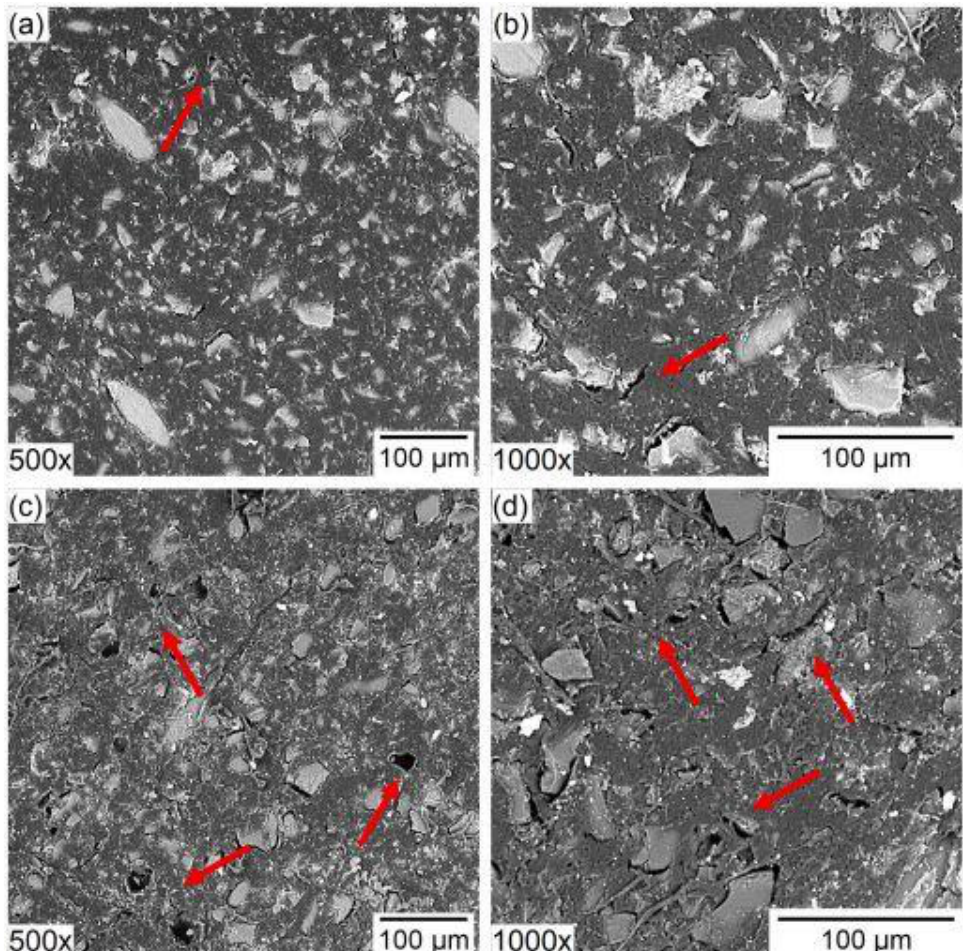
Figure 7. Scanning electron microscopy images of the surface of ( a , b ) original and ( c , d ) used anion- exchange membrane 500× and 1000× of magnification. Reprinted with permission from Ref. [68]. Copyright © 2021 Elsevier B.V.